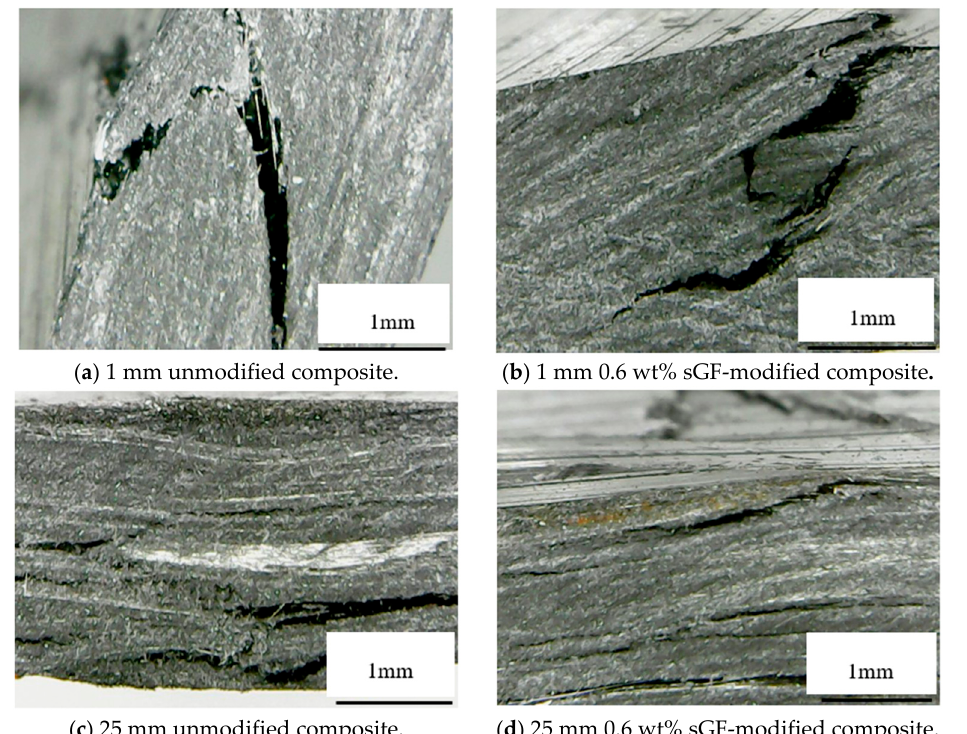
Figure 11. The representative stress-strain curves of 25 mm composites.